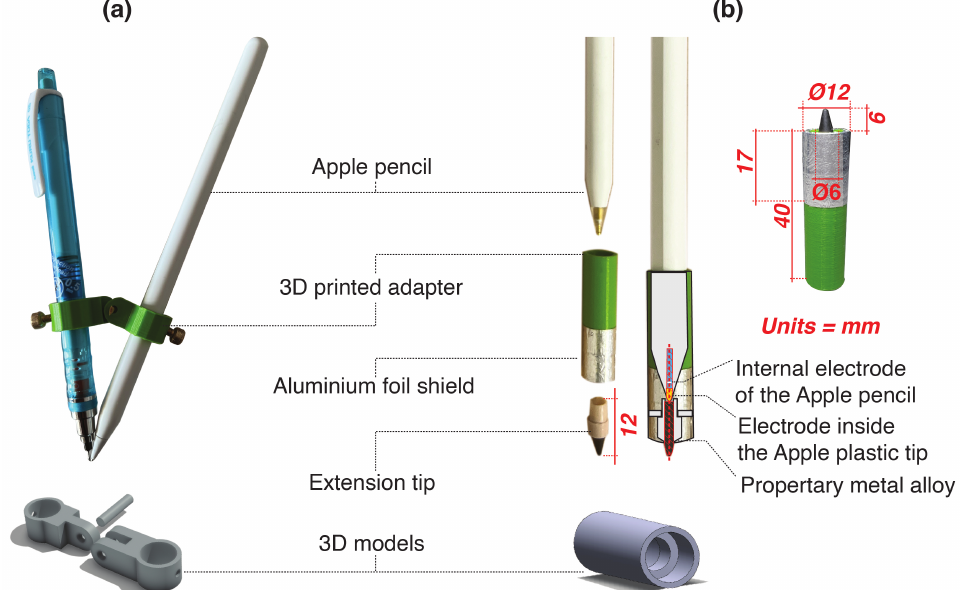
Figure 2. ( a ) Double pen adapter design. ( b ) Final design of the Hybrid Stylus